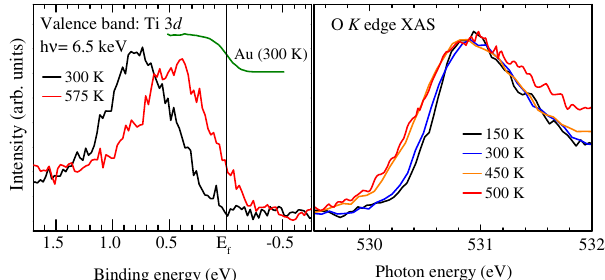
FIG. 4. Left panel: Close-up of the temperature dependence of the valence-band spectra of Ti 2 O 3 taken with h ν ≃ 6 . 5 keV (HAXPES SPring-8), together with the Au Fermi cutoff as E reference. Right panel: Close-up of the temperature dependence of the O K -edge XAS spectra of Ti 2 O 3